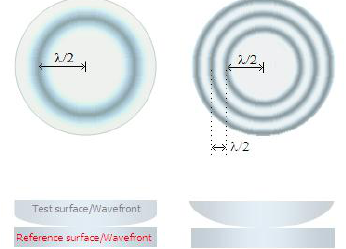
Figure 5: Interference pattern formation for curved surfaces (image source: http://www.telescope-optics.net/testing_optical_quality.htm#prevent)